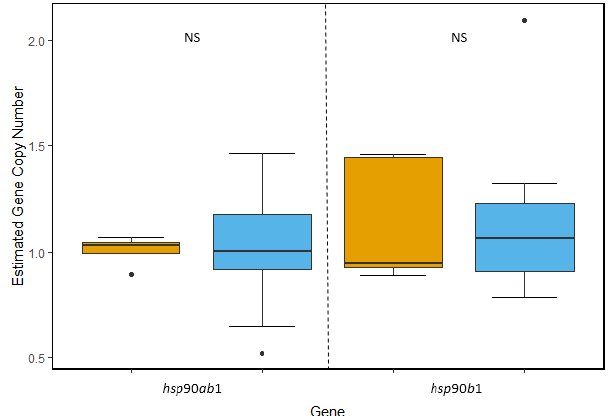
Figure 2. Comparison of estimated gene copy number of two isoforms within the hsp 90 gene family. The average copy number of ancestrally constitutive isoform hsp 90 ab1 was determined to be 1.07 copies per T. bernacchii genome (blue) and 1.01 copies per N. angustata genome (orange). Within the inducible isoform hsp 90 b 1, T. bernacchii had an average of 1.1 copies and N. angustata had an average of 1.14 copies per haploid genome. No significant difference in average copy number was observed between species for either of the two isoforms. Box and whiskers represent quartile ranges with circles representing